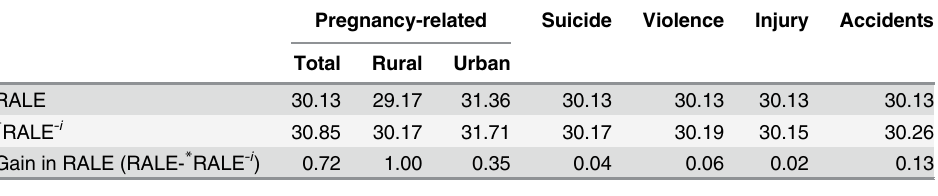
Table 4. Reproductive age life expectancy (RALE) from all deaths and after complete elimination of specific causes of death ( * RALE -i ), females aged 15 – 49, Zambia, 2010 Pregnancy-related Suicide Violence Injury Accidents Total Rural